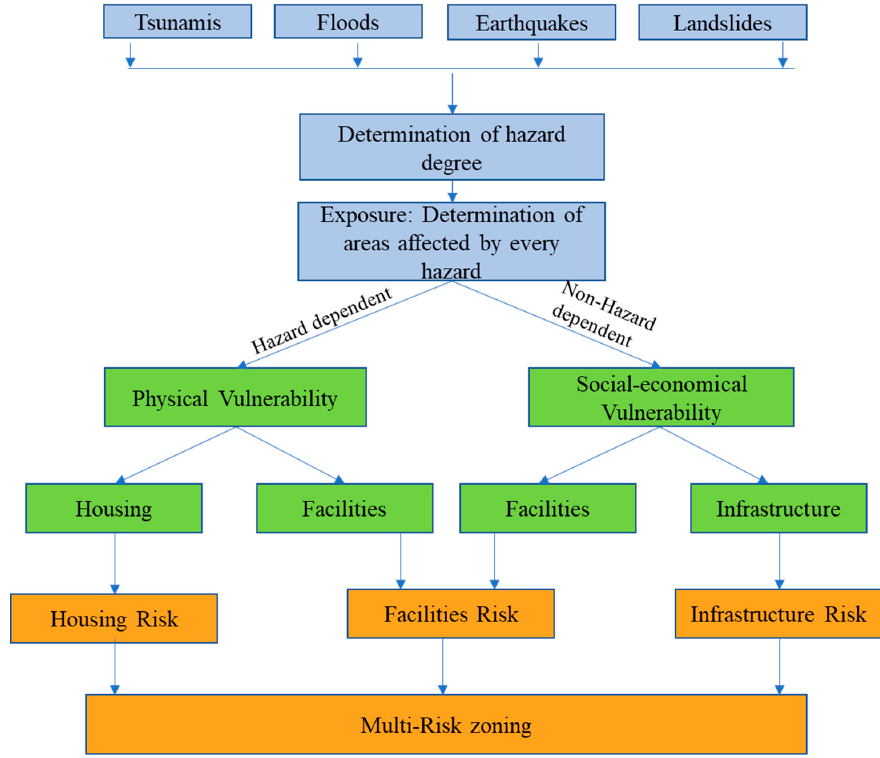
Figure 3. Scheme of the multi-risk assessment methodology. The hazard risk is calculated for